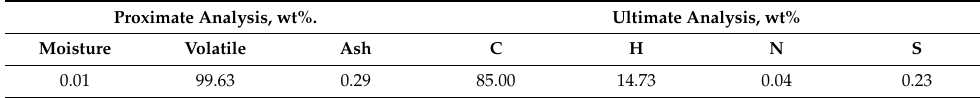
Table 1. Ultimate and proximate analysis of the polypropylene sample.